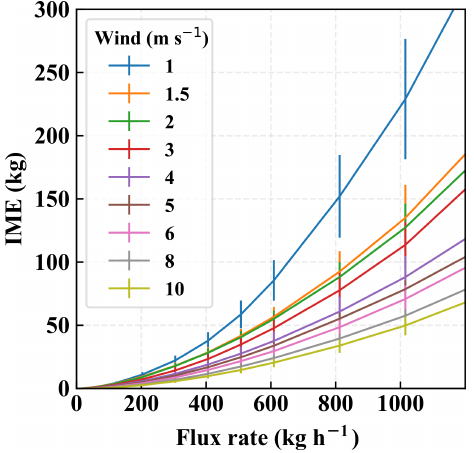
Figure 6. Mean and standard deviation of the IME associated with a range of flux rates under various background wind speeds from 1 to 10ms − 1 . The detection threshold is 500ppmm − 1 .